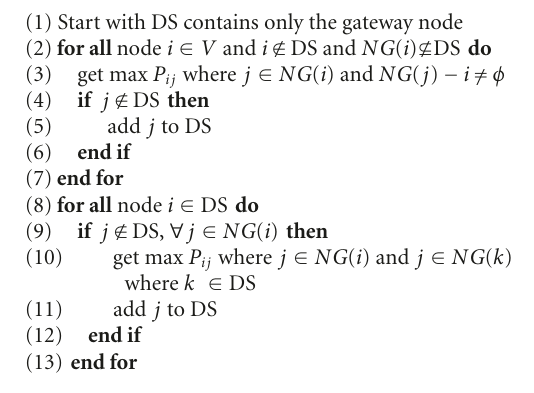
Algorithm 1: Calculation of the dominating set (DS) based on previous contact duration